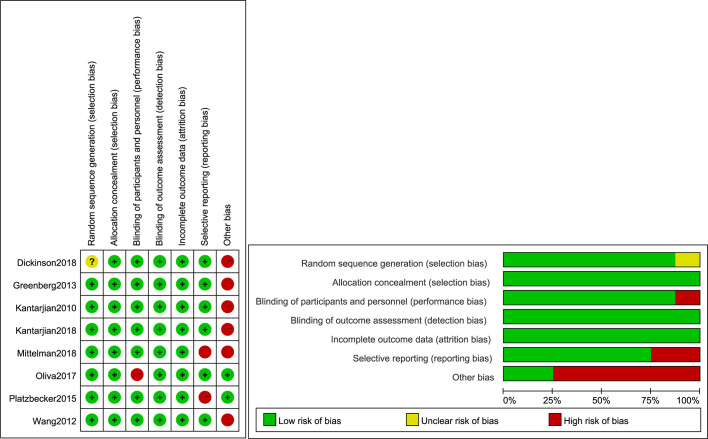
Quality assessment of the included comparative studies. +, Low risk of bias; –, high risk of bias; ?, unclear risk of bias.